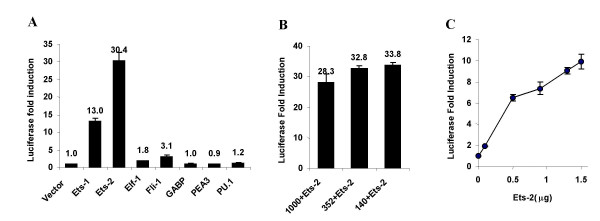
Transactivation of the Tkdp-1 promoter by Ets-2. A) Effects of different Ets family transcription factors on reporter expression from the 1000 bp Tkdp-1 promoter-Luc reporter construct in JEG-3 cells. Luc activities (means ± SEM; n = 3) are expressed relative to that of the basal activity of the 1000 bp construct. Following values differ significantly (p < 0.05): 1000 vs. 1000+Ets-1 and Ets-2; 1000+Ets-1 vs. 1000+Ets-2. B) Effect of Ets-2 on the transcriptional activities of three 5/-truncated Tkdp-1 promoter-Luc reporter constructs 1000, 352 and 140 in JEG-3 cells. Luc activities are expressed relative to that of the basal activity of each of the truncated constructs and data are shown as mean ± SEM (n = 3). For each truncated construct, the fold-induction in reporter activity after co-transfection with Ets-2 is significantly different from that without Ets-2 (P < 0.05). C) Effect of increasing concentrations of Ets-2 on the activity of the 1000 bp Tkdp-1 promoter-Luc reporter construct. Luc activities are expressed relative to that of the basal activity of the 1000 bp construct and data are shown as mean ± SEM (n = 3). Following values differ significantly (p < 0.05): 1000 vs. 0.5 μg, 0.9 μg, 1.3 μg and 1.5 μg Ets-2.